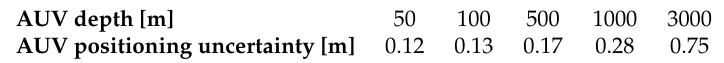
Table 11. Estimated position uncertainties due to surface ship attitude (1 σ ).